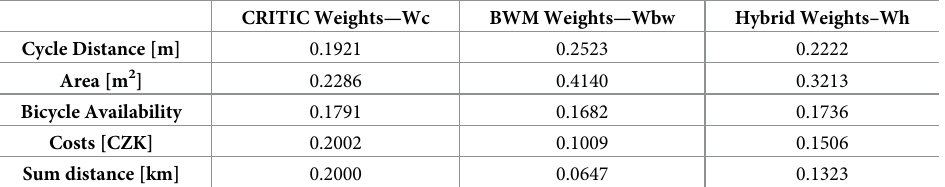
Table 16. Hybrid criteria